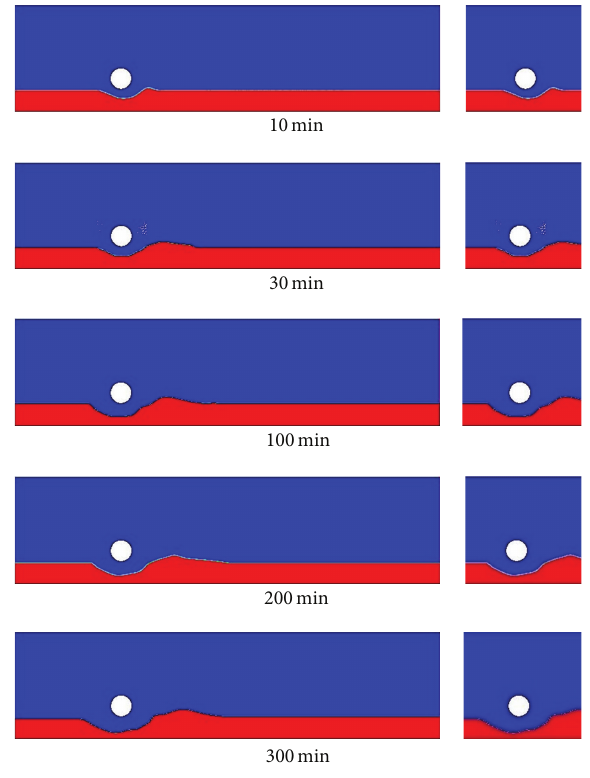
Figure 7: Bed profiles during the development of scouring.